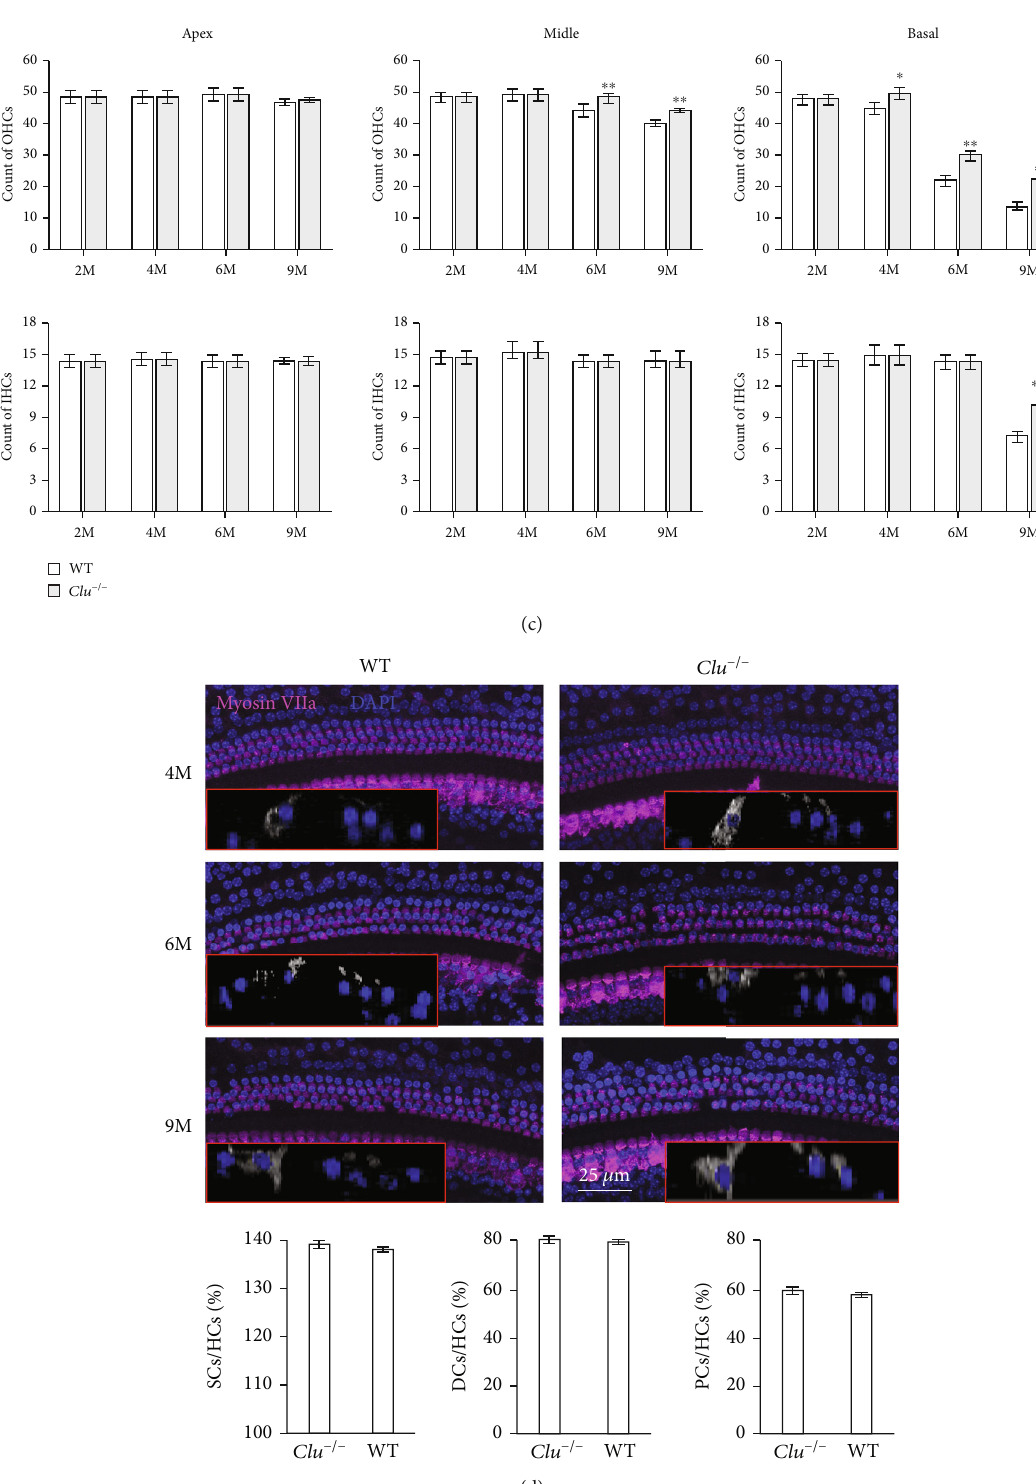
Figure 5: Assessment of age-related morphology of hair cells and supporting cells. (a) Cochlear basilar membrane immunostaining in P2m, P4m, P6m, and P9m Clu − / − mice. (b) Cochlear basilar membrane immunostaining in P2m, P4m, P6m, and P9m WT mice. The number of remaining hair cells in Clu − / − mice was signi fi cantly higher than that in WT mice at the same age. (c) Quanti fi cation of OHCs and IHCs in mice at P2m, P4m, P6m, and P9m across all tested frequencies in WT and Clu − / − mice. Data are presented as the mean ± SD . ∗ p < 0 : 05 , ∗∗ p < 0 : 01 . N = 6 . (d) Quanti fi cation of supporting cells at P4m, P6m, and P9m in WT and Clu − / − mice. The red box shows a typical section after three-dimensional reconstruction. The percentages of supporting cells and hair cells showed no signi fi cant di ff erences between WT and Clu − / − mice. N = 6